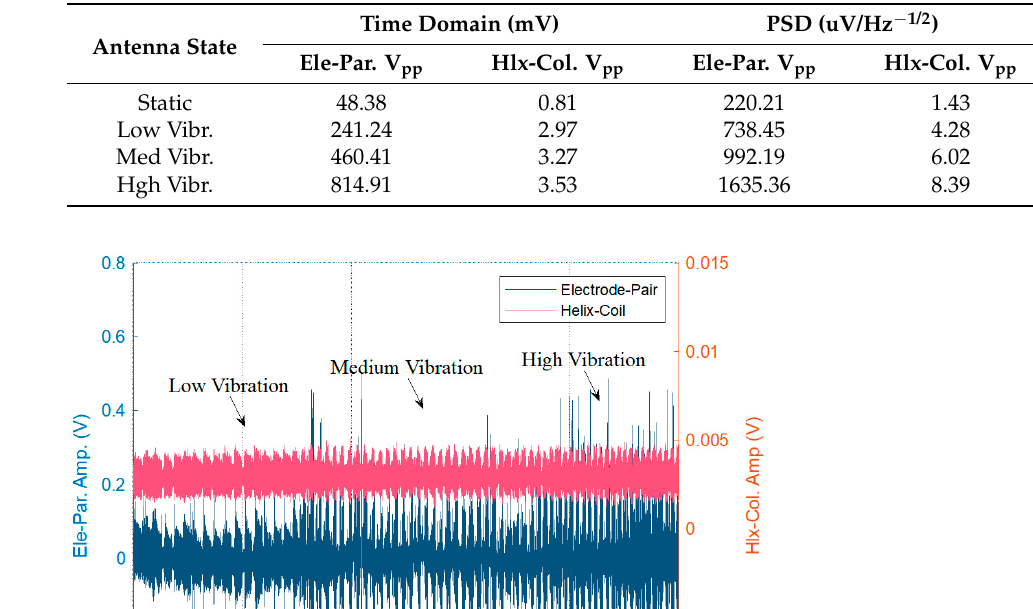
Figure 7. Frequency domain of experimental section signals from static to vibrations.